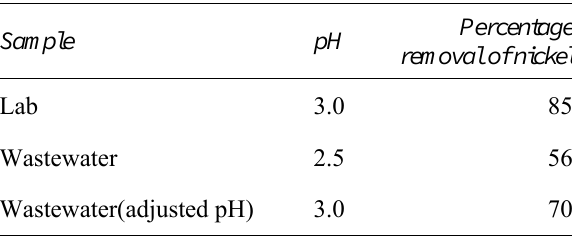
Table 3: Adsorption experiment on simulated water